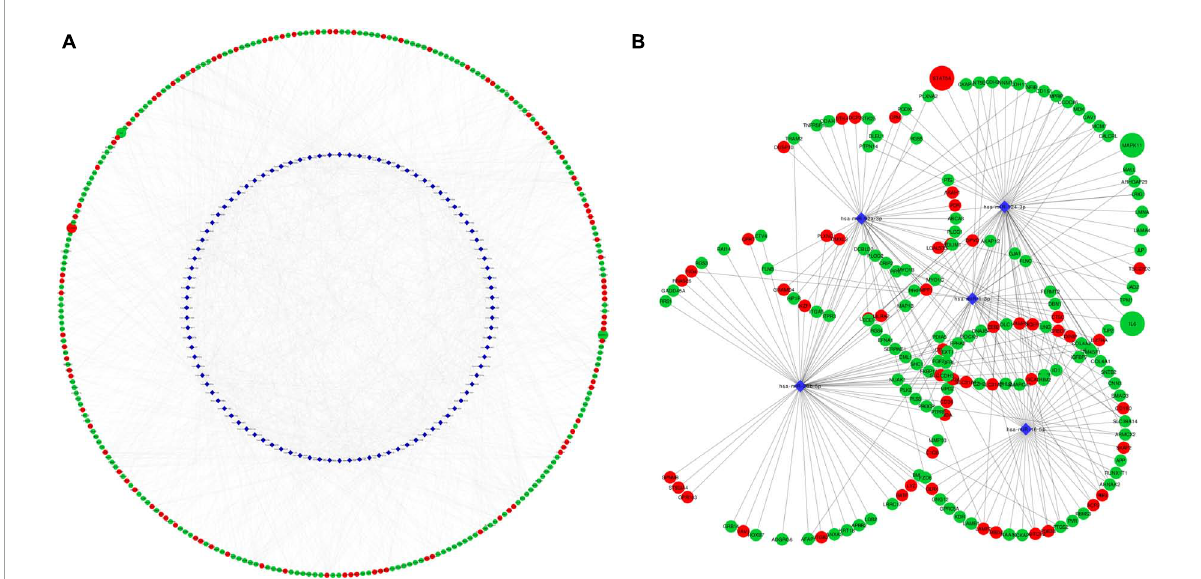
FIGURE6 Network representation of microRNA-mRNA target interactions. (A) Shows interactions between 96 MicroRNA and 285 DEG in EPCs. Hub microRNAs were selected according to CytoHubba MCC coefficient (B) . IL6, STAT5A and MAPK11 are highlighted in larger size. Red color rep-resents up-regulated genes and green color down-regulated. Circle represents mRNA and blue diamond’s represents microRNA. MCC, maximum clique